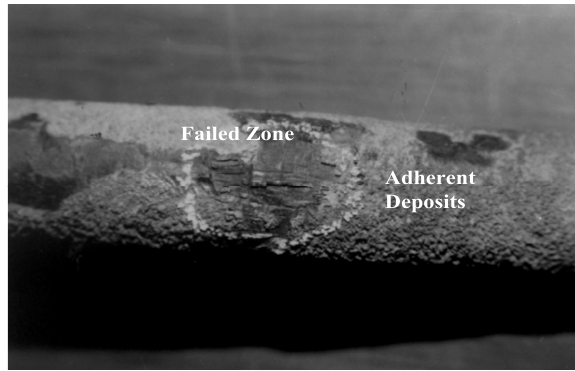
Figure 4. Grain boundary sulfide attack on eh outer surface of the superheater